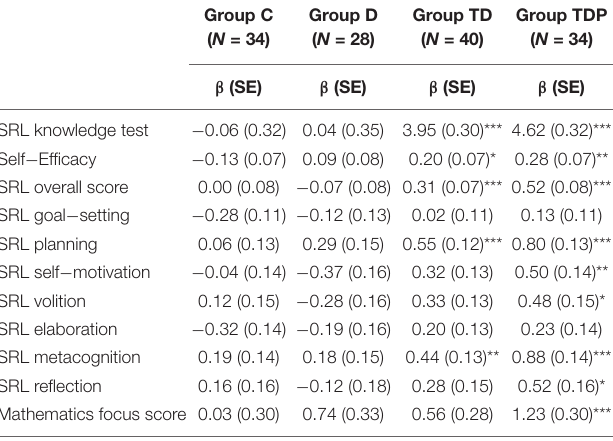
TABLE 3 | Planned contrasts: gains of the four experimental groups from pre-test to